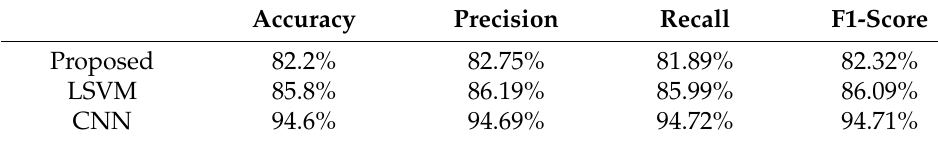
Figure 17. Confusion matrix of the proposed model. Table 1. Evaluation metrics of the proposed, LSVM, CNN